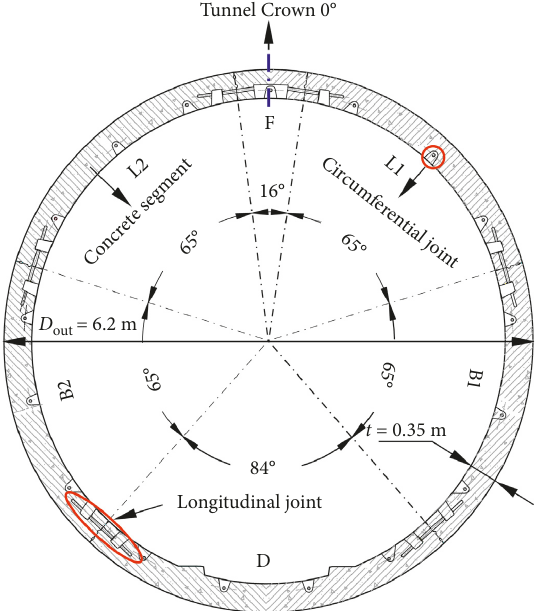
Figure 1: Typical cross section of shield lining in